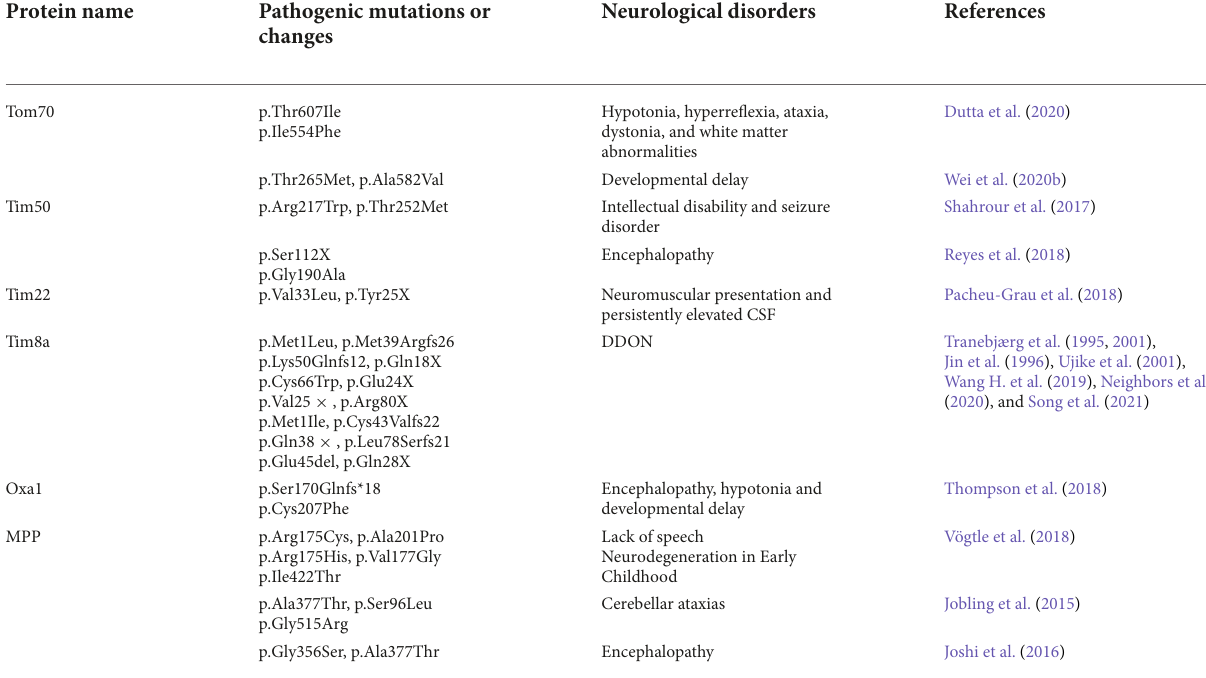
TABLE 4 Neurological diseases caused by protein variants involved in mitochondrial import